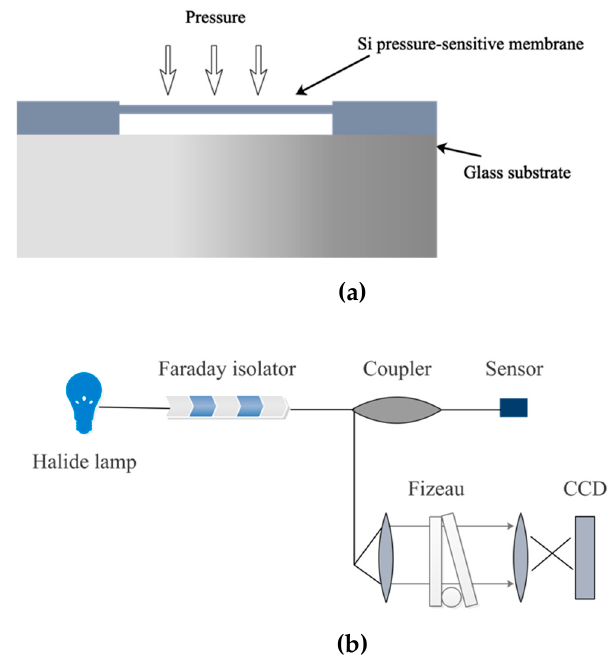
Figure 2. Schematic drawing of ( a ) the pressure-sensitive probe and ( b ) the experimental setup for pressure demodulation.